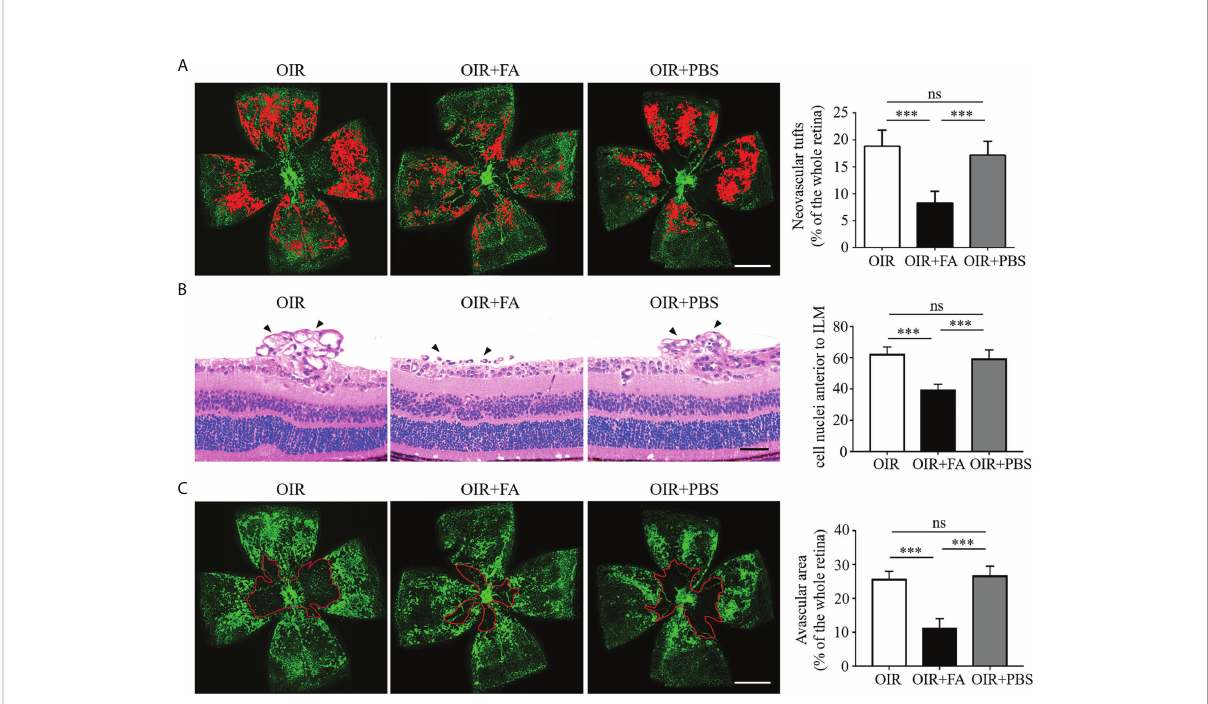
FIGURE 2 Anti-neovascular effect of FA in the OIR retina. (A) Representative images of isolectin-B4 staining on retinal whole-mounts showing neovascular tufts (painting in red). The area of neovascular tufts in the FA-treated group was signi fi cantly decreased compared with the untreated and PBS- treated groups. n = 10 mice. Scale bar, 1 mm. (B) H&E staining revealed less neovascular cells anterior to the ILM (black arrows) after FA treatment. n = 6 mice. Scale bar, 100 m m. (C) Retinal whole-mounts showed less avascular area (circled in red) in the FA-treated group than the untreated and PBS-treated groups. n = 10 mice. Scale bar, 1 mm. Data are presented as mean ± SEM. *** P < 0.001, ns, no signi fi cance. ILM, inner limiting